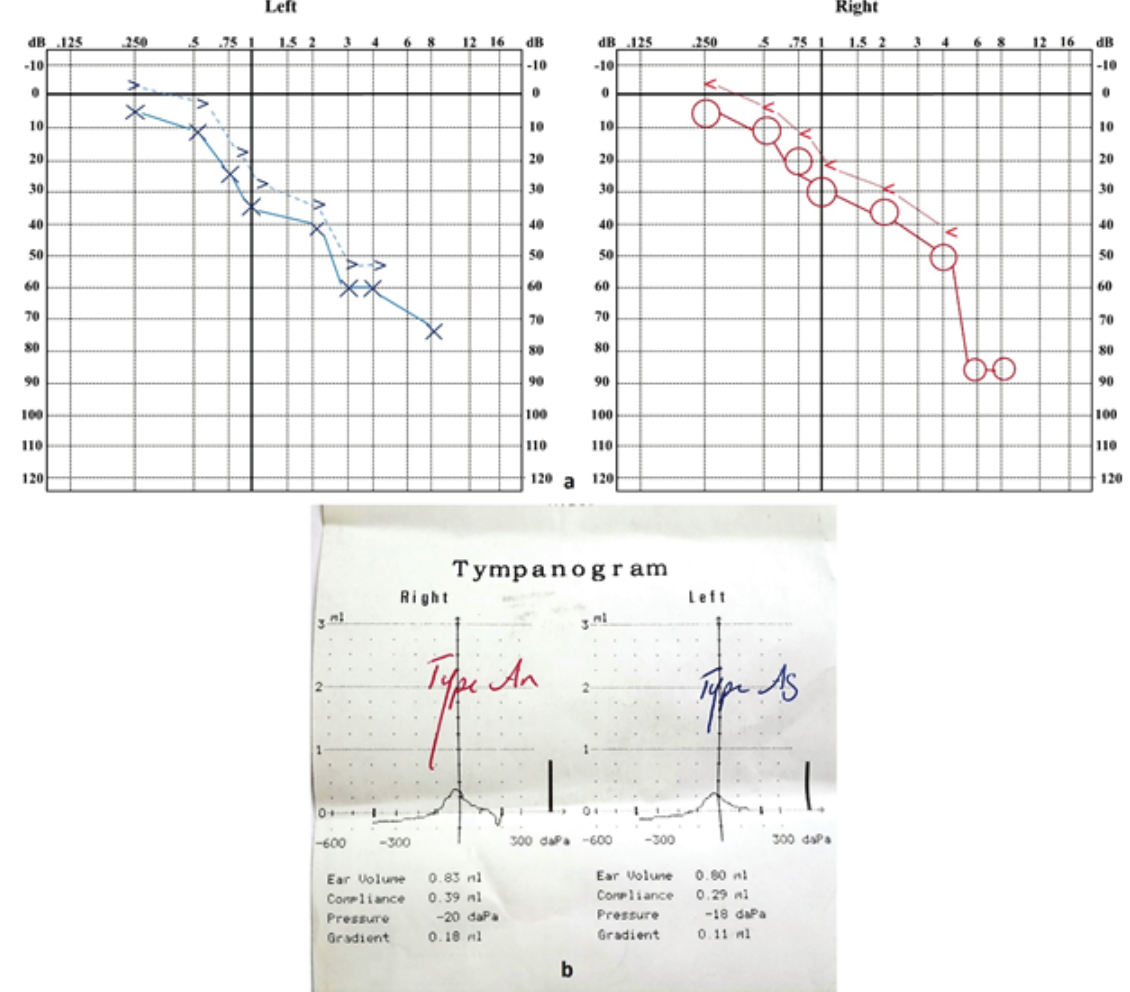
Figure 5. (a) Tympanogram of both ears in case V.3. (b) Audiograms of case V.3 showing sensorineural hearing loss in both